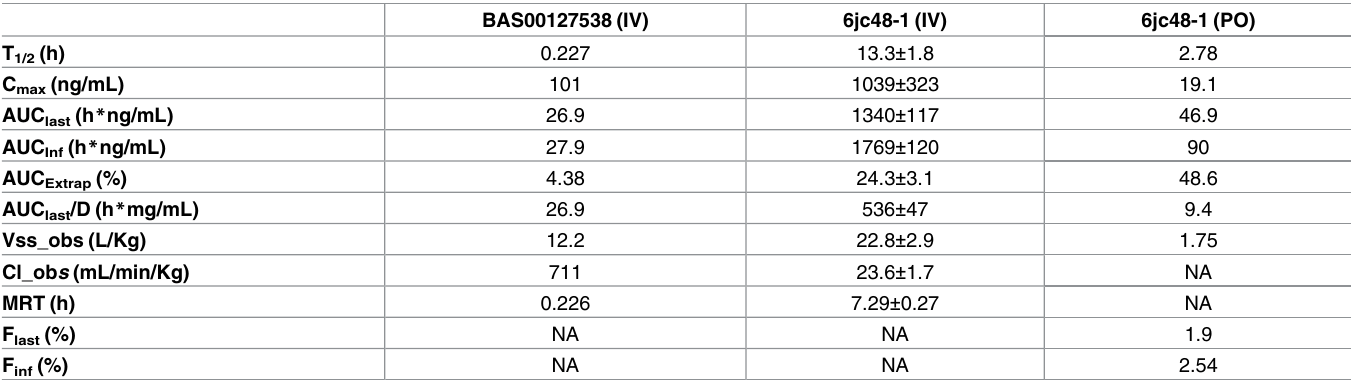
Table 4. Pharmacokinetic properties of